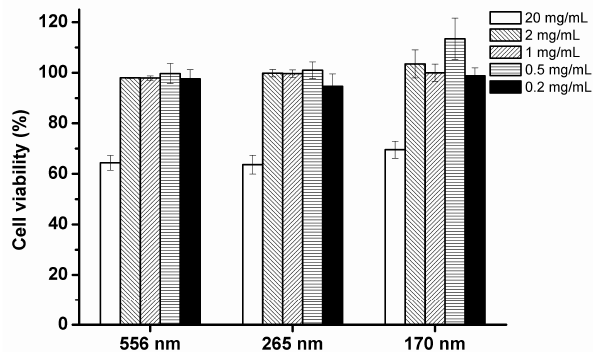
Figure 3. In vitro cytotoxicity of three different droplet size lipid-based emulsions at different sodium caseinate concentrations (20, 2, 1, 0.5, and 0.2 mg/mL) on Caco-2 cells measured by MTT assay. Cell viability was evaluated by the percentage of absorbance relative to control. The data were expressed as mean ± standard with three independent replicates.